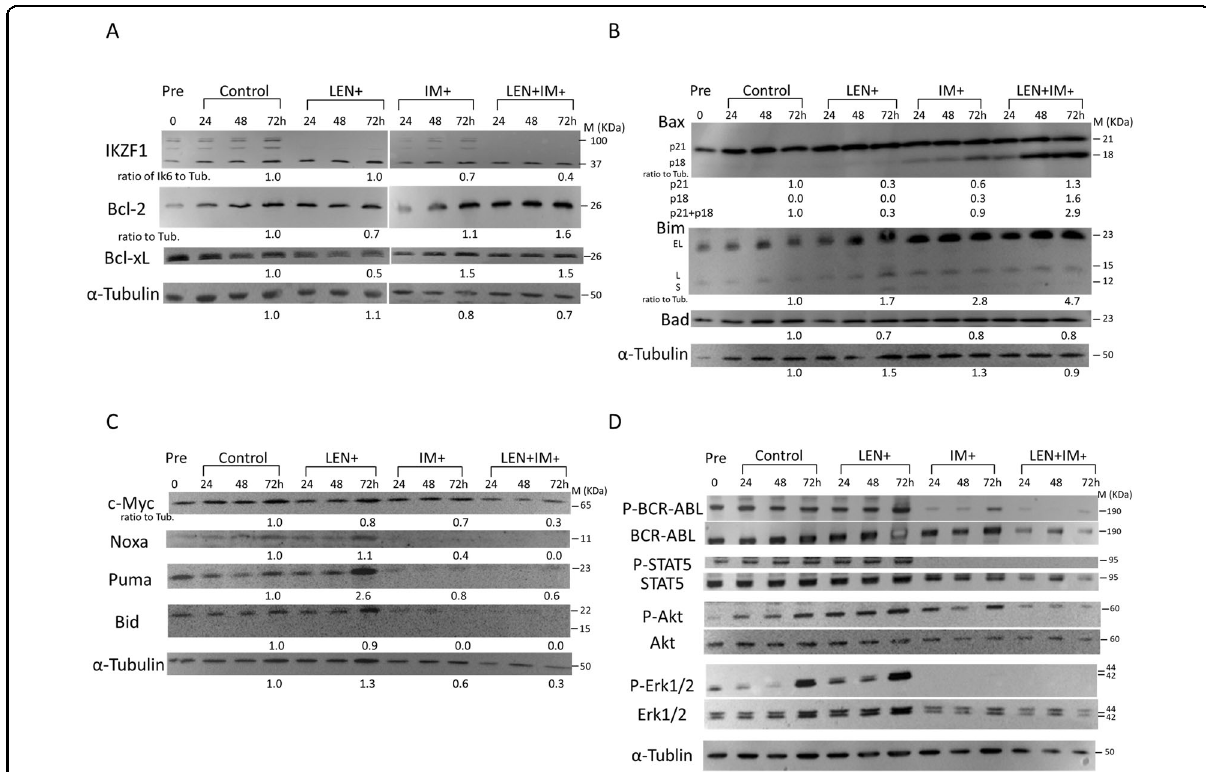
Fig. 5 Western blot analysis of changes in expression of apoptosis and signal transduction-related molecules after LEN and IM treatment. KOPN57bi cells were cultured in the presence or absence of LEN (5 μ M) and/or IM (0.5 μ M), and were harvested at 24, 48, and 72 h. For western blot analysis, the following antibodies were used; Bim, Bid, Puma, Akt, phospho-Akt, Erk1/2, phospho-Erk1/2, STAT5, and phospho-STAT5 (Cell Signaling Technology, Beverly, MA), Bad, Bcl-xl, Bcl-2, and Bax (BD Bioscience, Franklin Lakes, NJ), Noxa (Abcam plc, Cambridge, UK), and C-myc (Santa Cruz Biotechnology, Dallas, TX). The areas of bands at 72 h were quanti fi ed by densitometry and shown as the relative ratio to the control after compensation by α -tubulin expression. A Changes in apoptosis-inhibitory molecules. The blots were stained with speci fi c antibodies against IKZF1, Bcl-2, and Bcl-xL. B Changes in pro-apoptotic molecules. The blots were stained with speci fi c antibodies against Bax, Bim, and Bad. C Changes in pro- apoptotic BH3 only molecules. The blots were stained with speci fi c antibodies against c-Myc, Noxa, Puma, and Bid. D Changes in signal transduction- associated molecules. The blots were stained with antibodies against the whole and phosphorylated forms of signal transduction-associated